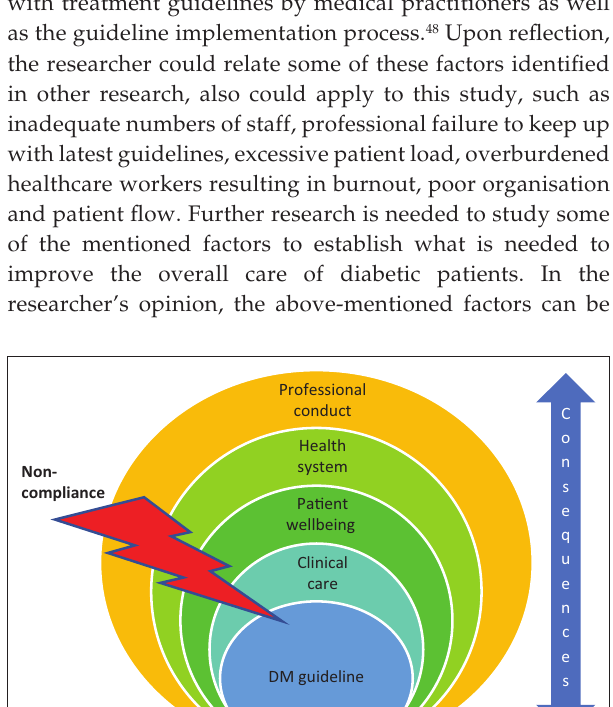
FIGURE 1: Multi-layered consequence of non-adherence with diabetes mellitus guidelines.